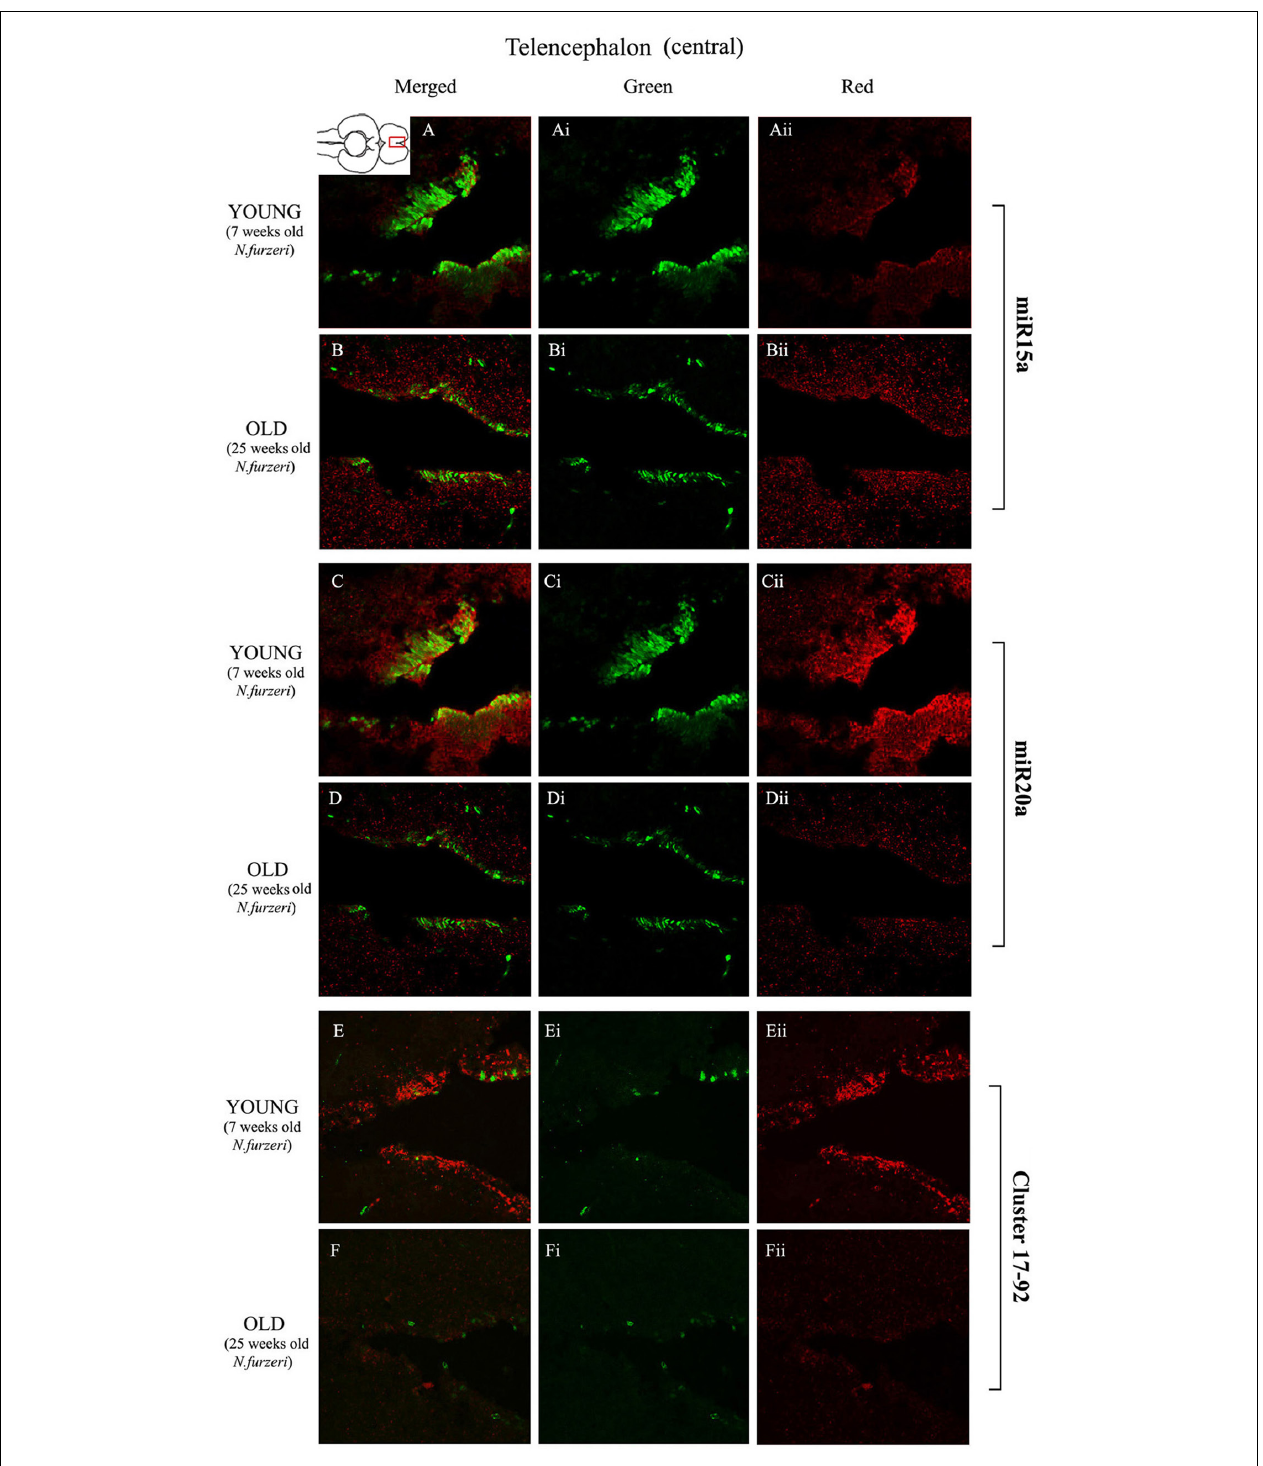
FIGURE 4 | Magnification of the central region of the telencephalon (cTEL) stained in green for PCNA by IHC, and in red for miR15 (A,B strips), miR20 (C,D strips) and Cluster17–92 (E,F strips) by ISH. The upper inset on A shows an overview of a horizontal brain section: the location of the cTEL is indicated by the red rectangle. The left column of the panel (A–F) shows the merged channels for the double staining; A,B